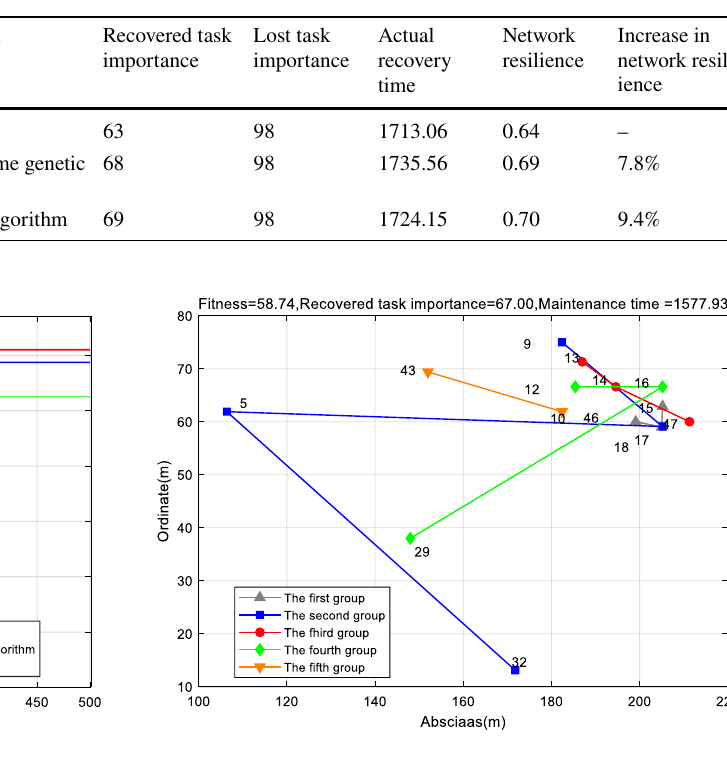
Fig. 11 Comparison of the evolution curve of optimal fitness on improved quotient model